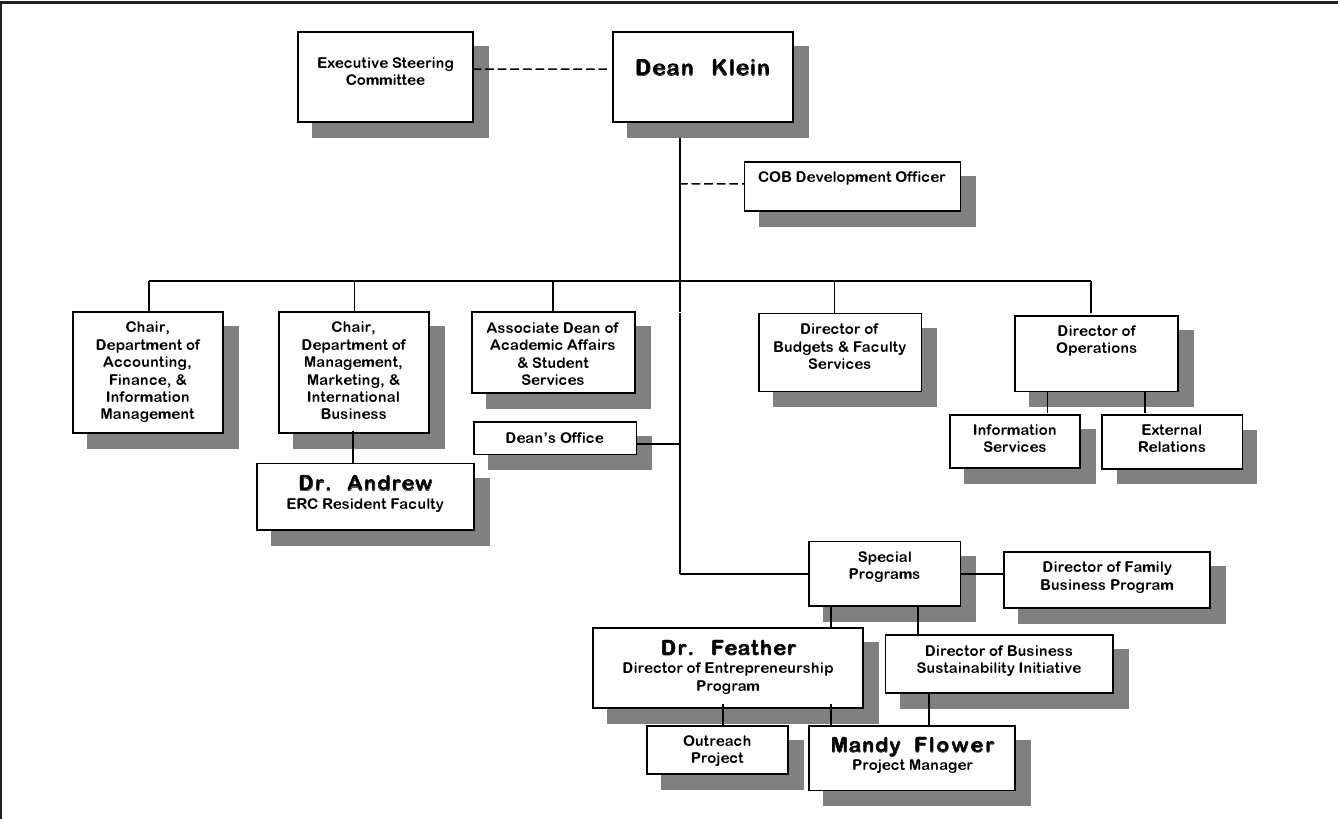
Figure 1. College of Business Organization